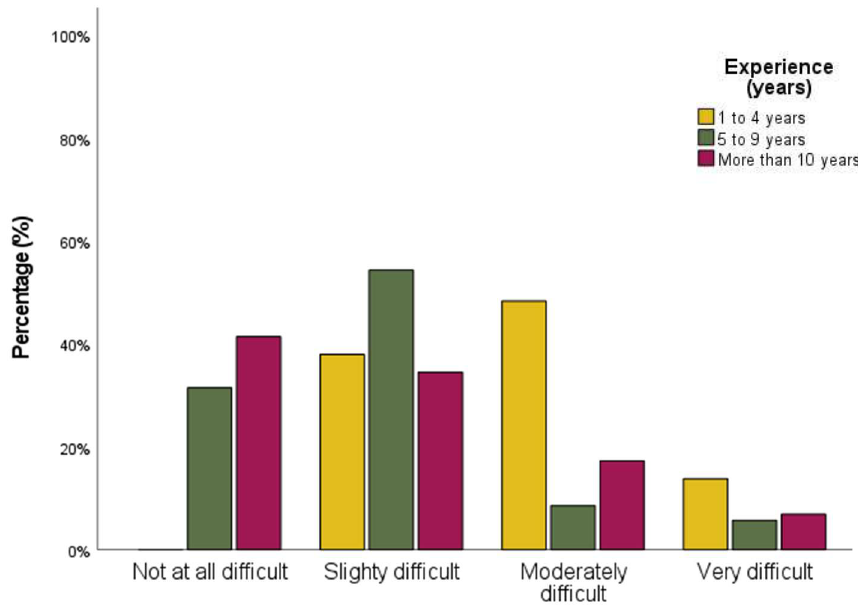
Figure 1. Bar graphs showing self-perceived difficulty in decision-making according to experience (years).